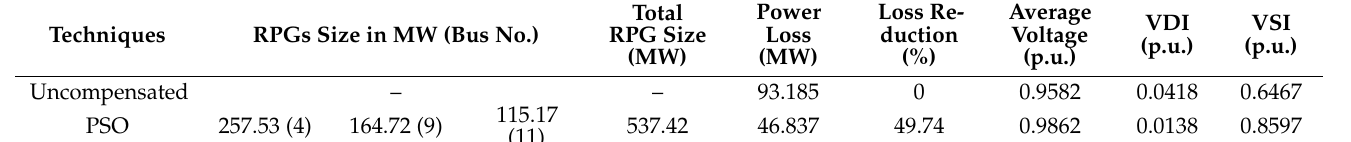
Figure 5. Comparison of the voltage profile before and after case 1 configuration. Table 4. Results for different RPG locations at unity power factor (UPF).